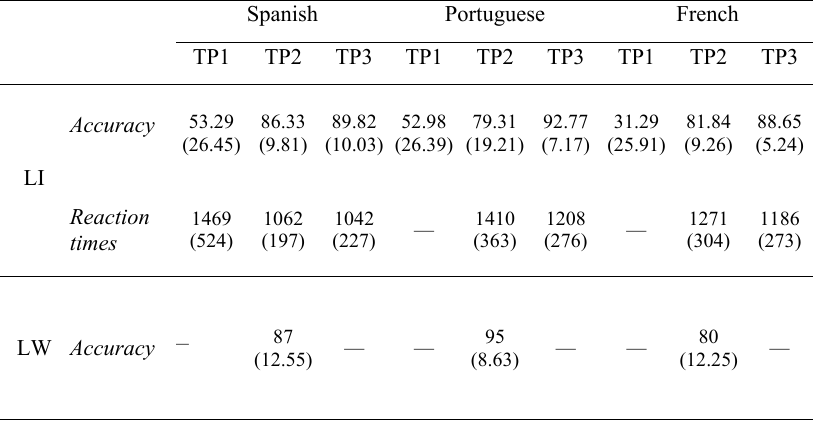
Table II. Mean percentage of correct responses, mean reaction time (ms) for Letter Identification, LI, at TP1 (October), TP2 (February-March) and TP3 (May-June) and Letter Writing, LW, at TP2, in Spanish, Portuguese and French. Standard deviations in parentheses. Spanish Portuguese